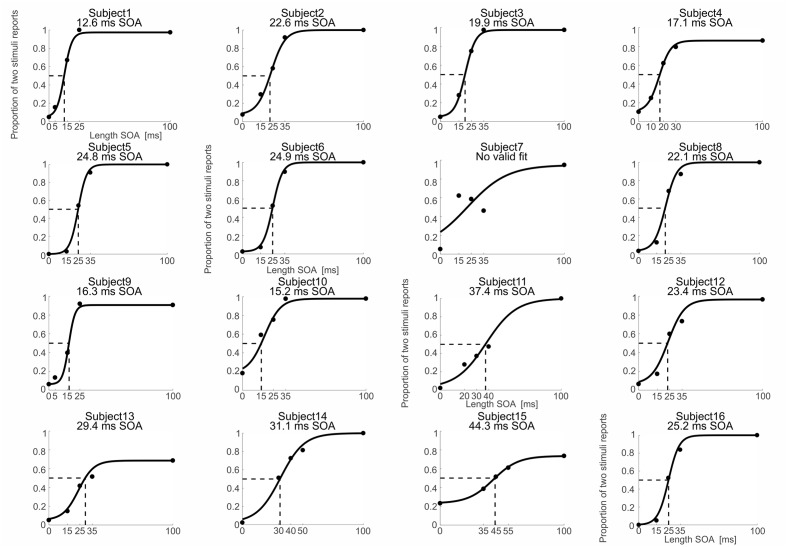
Behavioral and fitting data. Psychometric functions (black solid lines) were fitted to the individual proportion of ‘perceived two stimuli’ responses (black dots) as a function of the different SOAs. Black dotted lines indicate the SOA corresponding to a proportion of two stimuli reports of 0.5 (fitted intermedSOA). Exact fitted intermedSOAs for each subject are specified at the top of the individual figures. Note that for subject 7 the fit was not reliable so that subject 7 was excluded from further analyses.